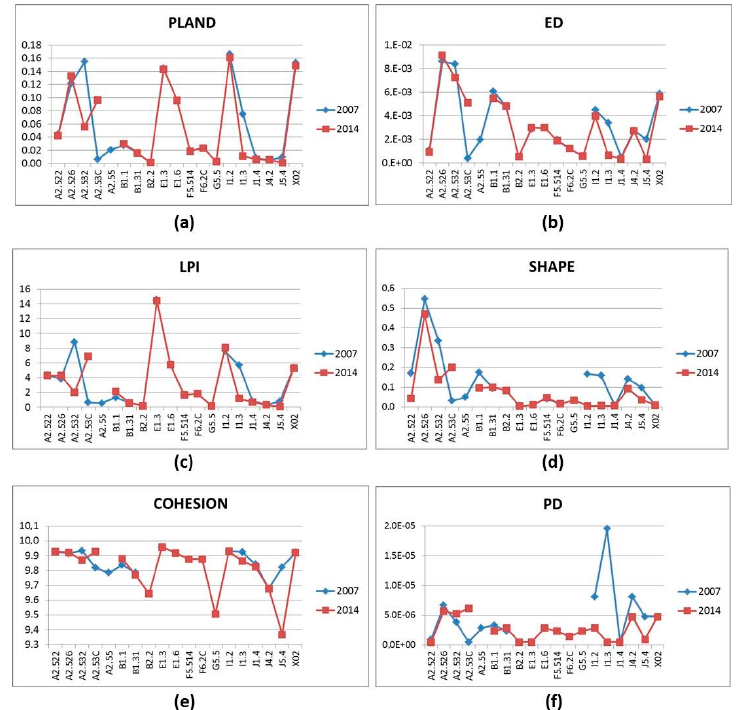
Figure 13. Diagrams comparing: ( a ) PLAND, percentage of landscape; ( b ) ED, edge density; ( c ) LPI, largest patch index; ( d ) SHAPE, mean patch shape ratio; ( e ) COHESION, patch cohesion index; and ( f ) PD, patch density, at the SC site in 2007 and 2014.